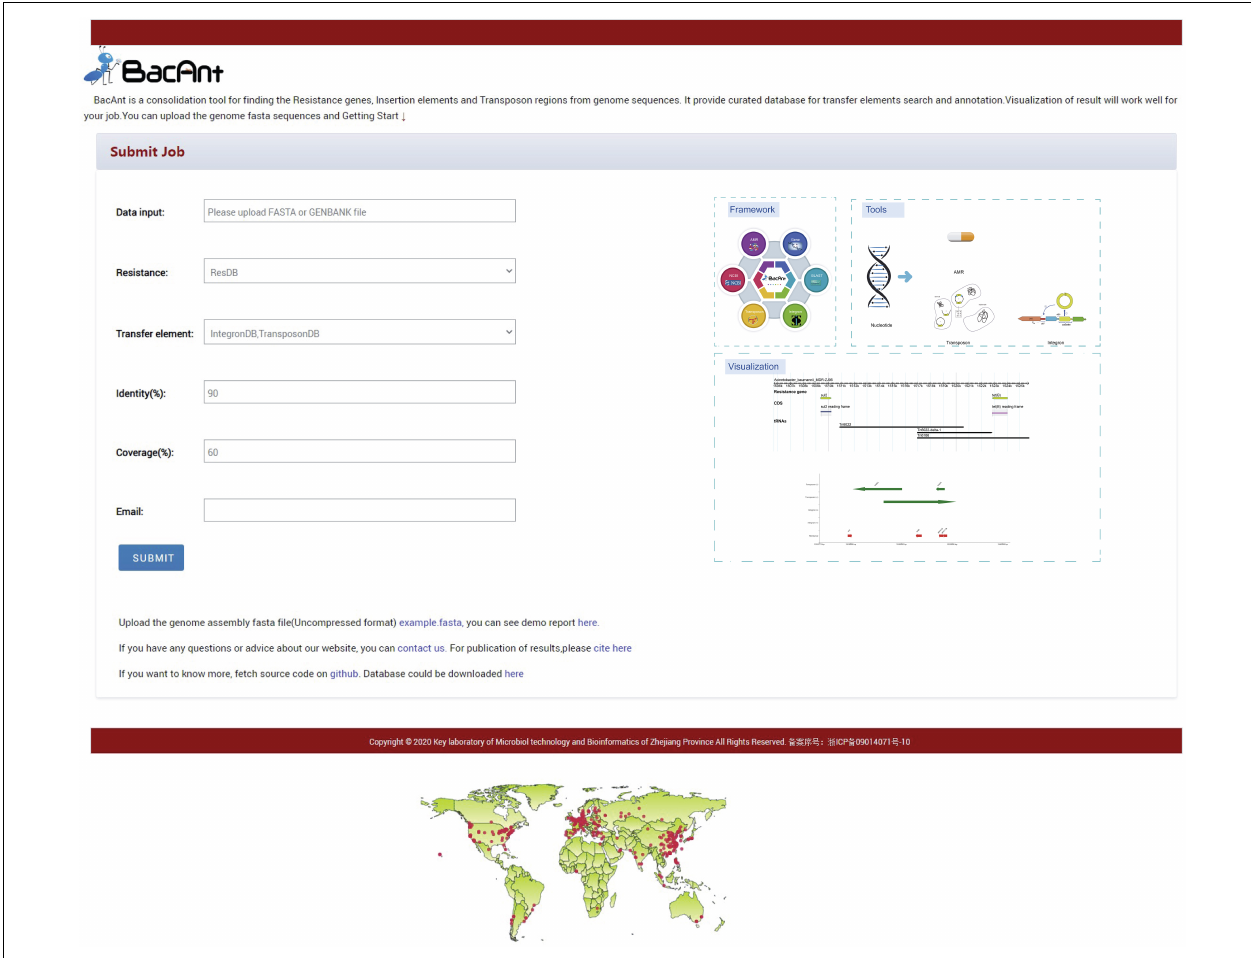
FIGURE 1 | Screenshots of the BacAnt web interface. Users upload an assembled file from their local personal computer and select the desired annotation database. “Framework” lists the public database and tools integrated in BacAnt; “Tools” functions for whole genome sequence annotation based on user uploaded sequence(s); “Visualization” allows to visualize the annotation results for uploaded sequence(s).